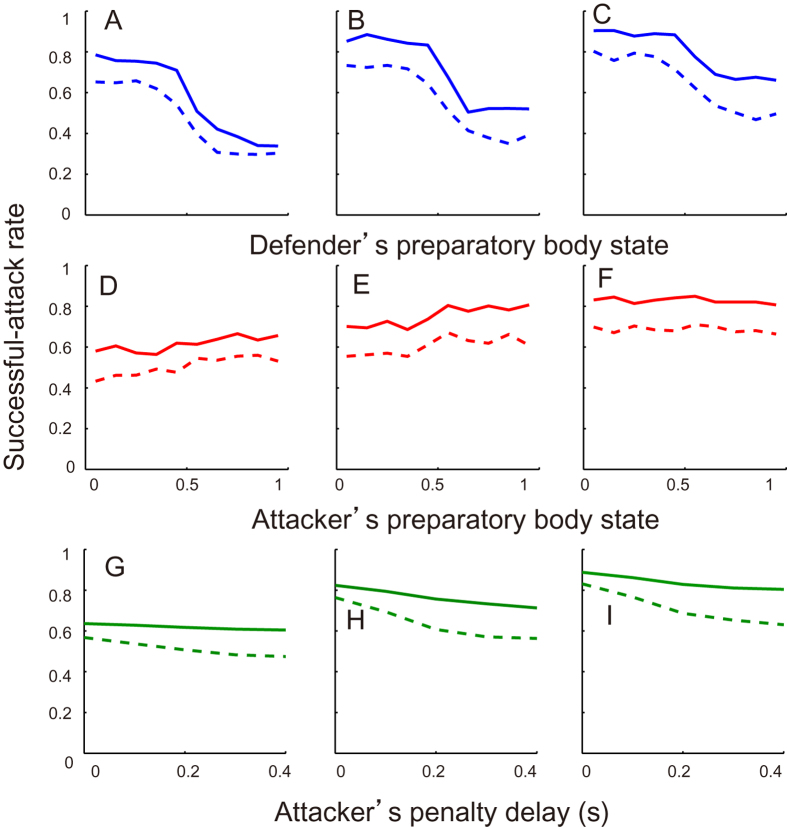
Effect of parameters on the attack-and-defend system.Simulated successful-attack rate histogram as a function of defender’s (A–C) and attacker’s preparatory body state (D–F) and attacker’s penalty delay (G–I) in observed (solid) and non-observed (dashed) condition. Columns of A, B and C indicated that defender’s initial delays τinitial were set to 0, 0.1, and 0.2 s, respectively. All data in Fig. 3A-F and Fig. 3G–I was submitted as Supplementary Dataset 1 and 2.